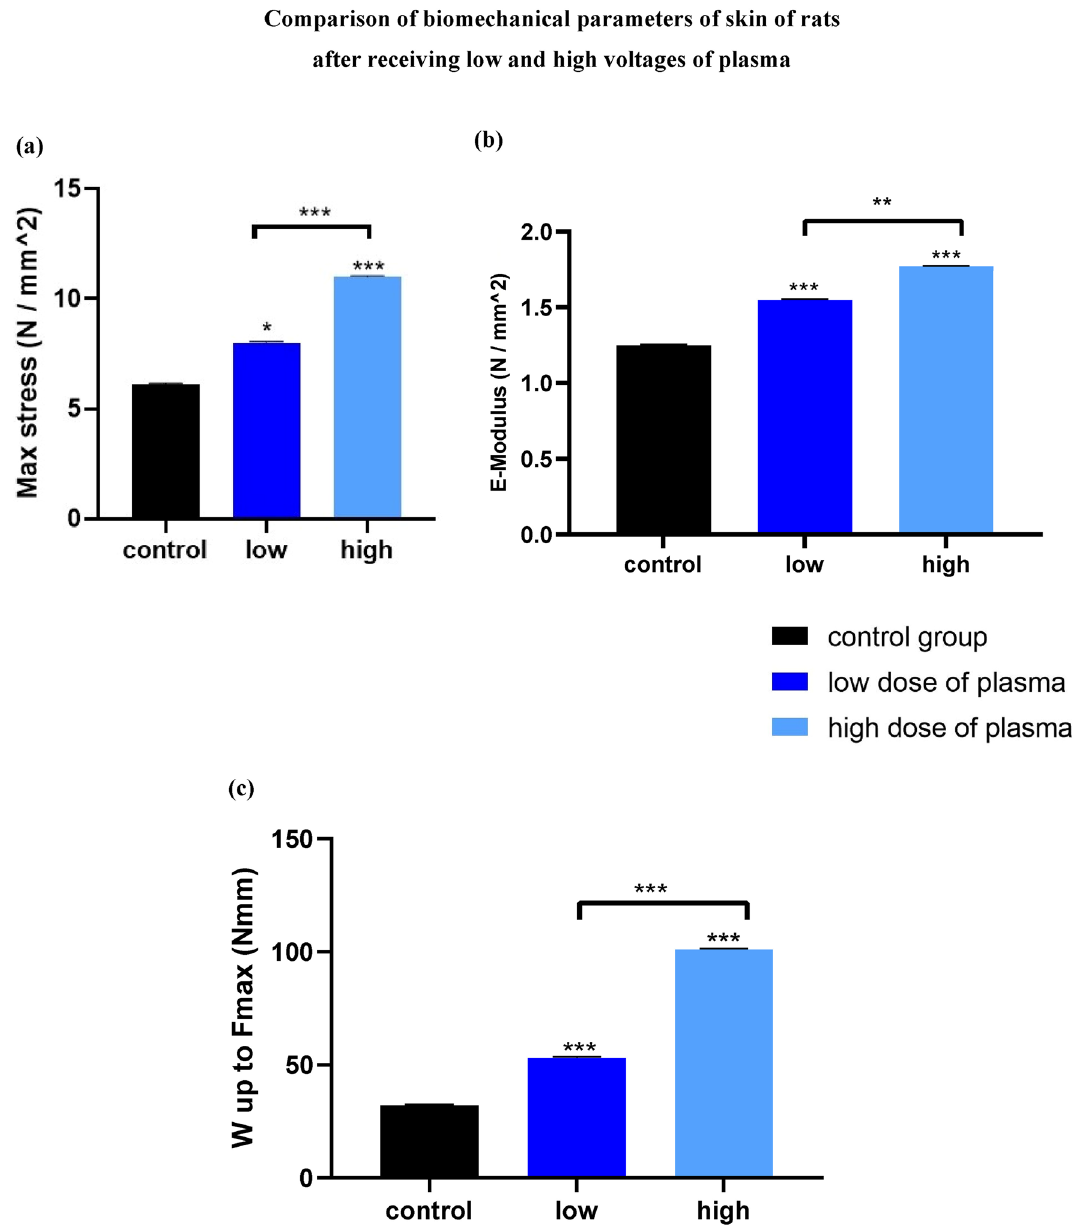
***p < 0.001, significant differences compared with the control group (without treatment